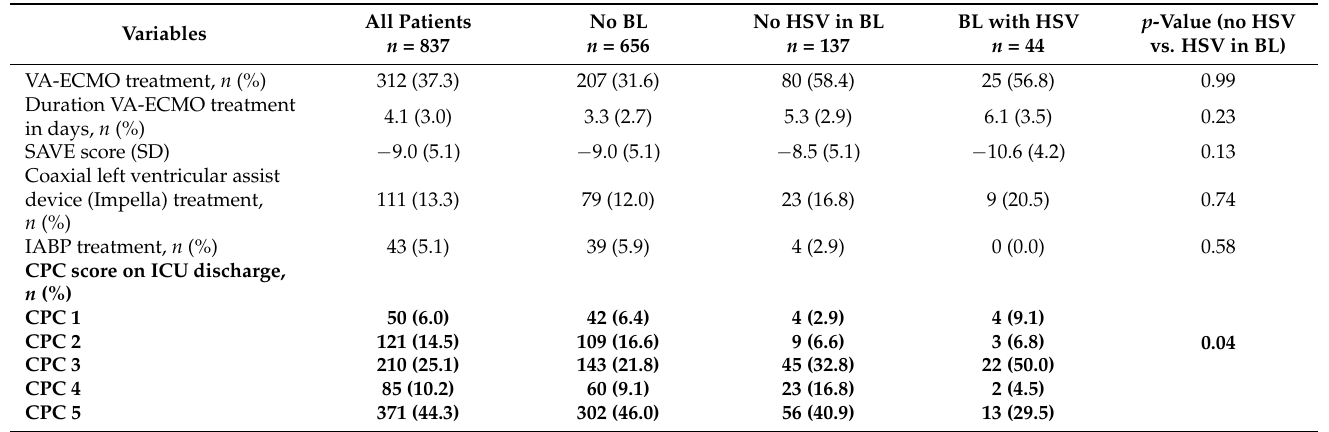
Table 3. Concomitant pathogens detected seven days prior until seven after first HSV occurrence.